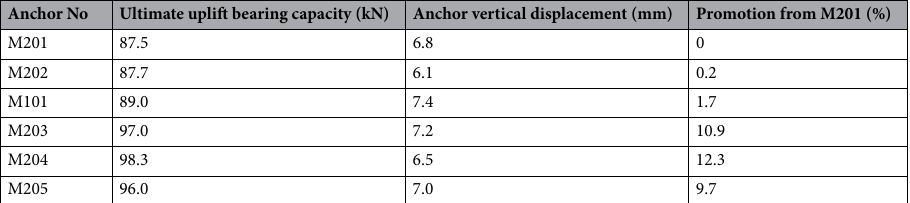
Table 5. Ultimate uplift bearing capacities and vertical displacement of group M2.